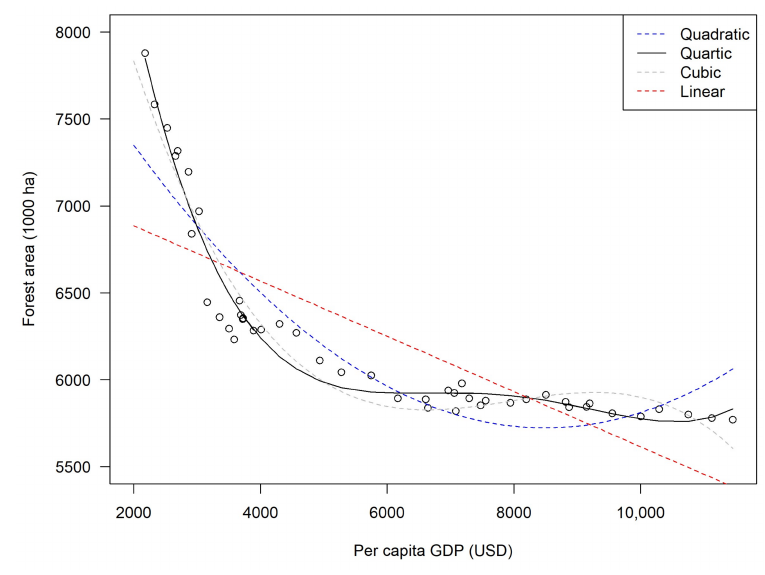
Figure 4. Results of curve fitting by linear, quadratic, cubic, and quartic